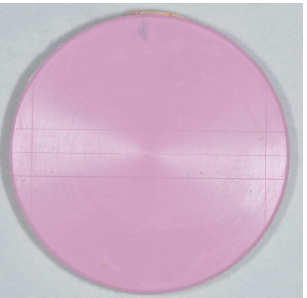
Figure 1. Vinyl polysiloxane (VPS) sample.